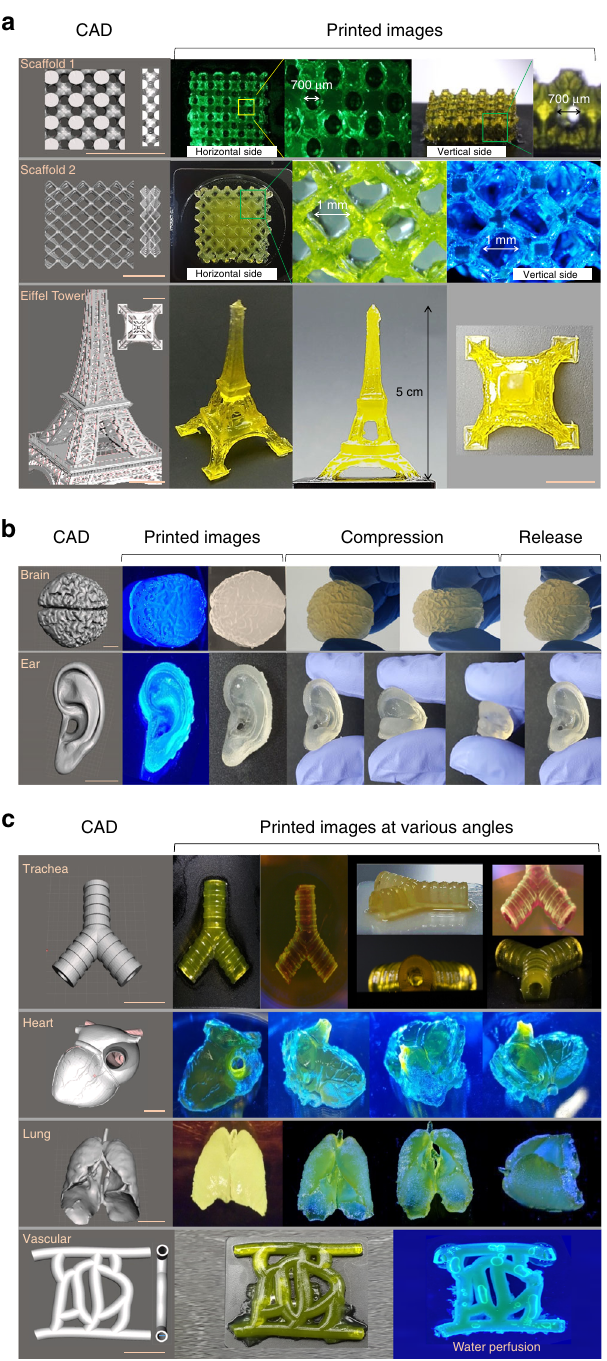
Fig. 5 Printability of 30%Sil-MA using DLP printer. a Porous scaffold and Eiffel Tower imitation; (l) CAD images depicting scaffolds and Eiffel Tower and (r) printed images. Printed scaffolds had small pores around ~700 μ m and Eiffel Tower had small holes and grid on the surface. b Ear and brain mimicked shape; (l) CAD images depicting the ear and brain and (r) printed images. Printed products were not damaged when they were compressed by fi ngers tightly and they were back to their original shape when relaxed his fi ngers. c Trachea, heart, lung, and vessel mimicked shape; (l) CAD images depicting the trachea, heart, lung, and vessel and (r) printed images at various angles. Printed products by DLP using Sil-MA showed complex structure re fl ecting their CAD images, including veins, arteries, folds, and holes. Scale bar indicates 1